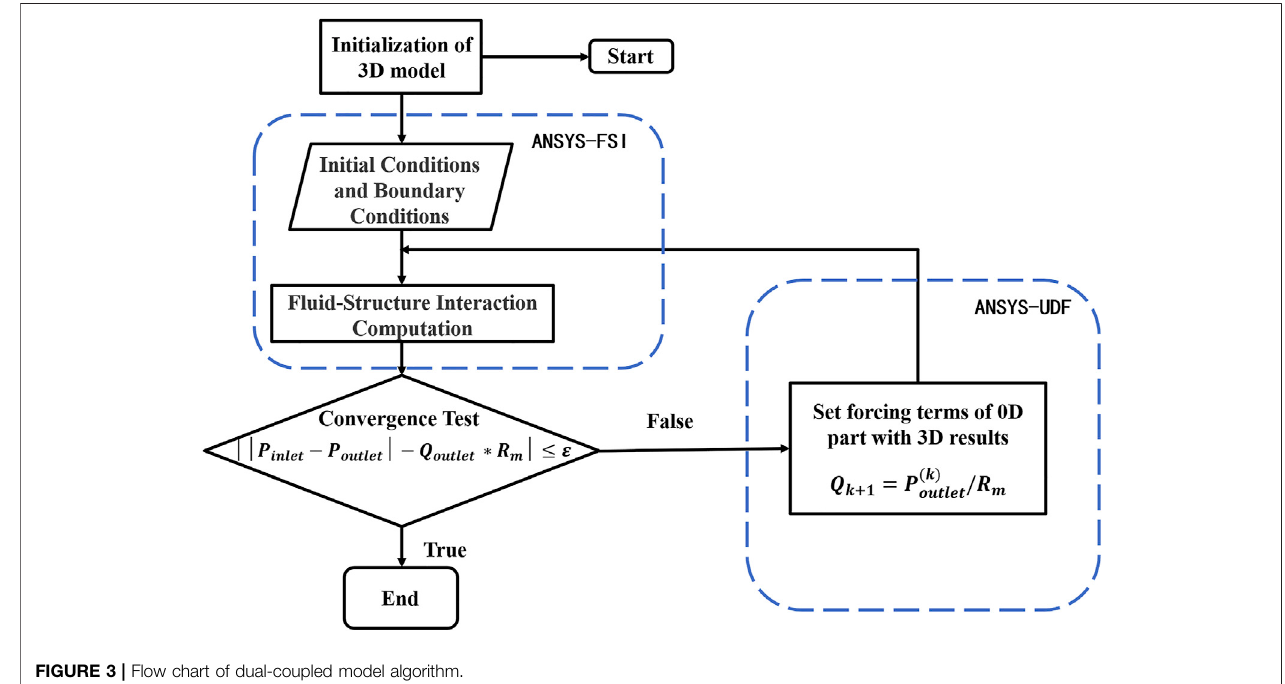
FIGURE 3 | Flow chart of dual-coupled model algorithm.